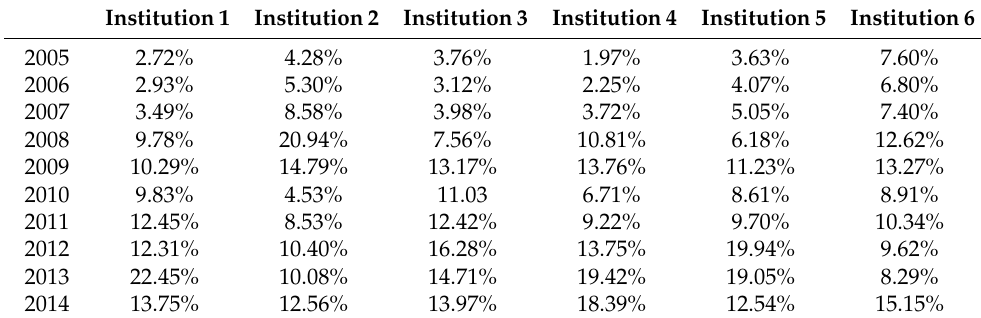
Table 1. Percentages of mortgages’ defaulted exposures per year over the period of